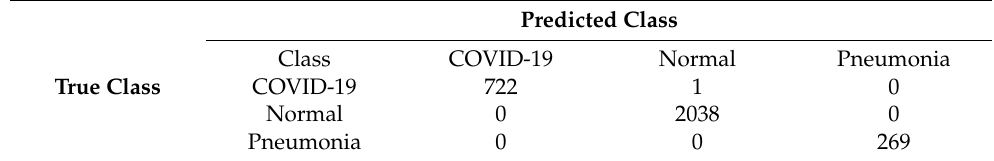
Table 4. Confusion matrix attained by ShuffleNet in three-class classification using chest radiographs.